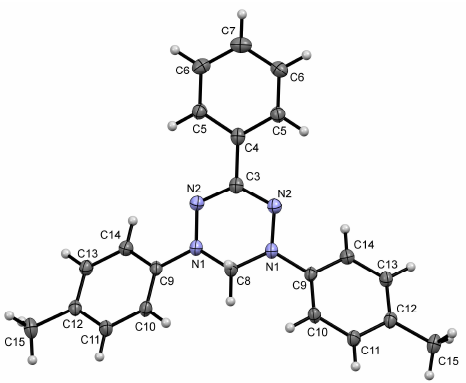
Figure 2. The crystal structure of compound 3a . All atoms are shown as probability ellipsoids of atomic displacements ( p = 50%).